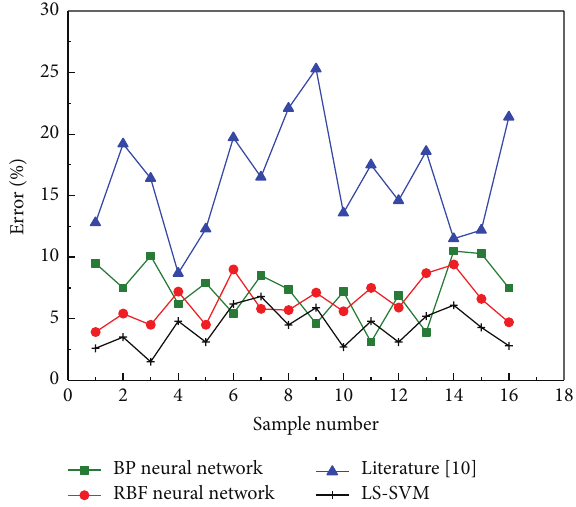
Figure 8: Fitting error comparison of the LS-SVM model, literature [10], and neural